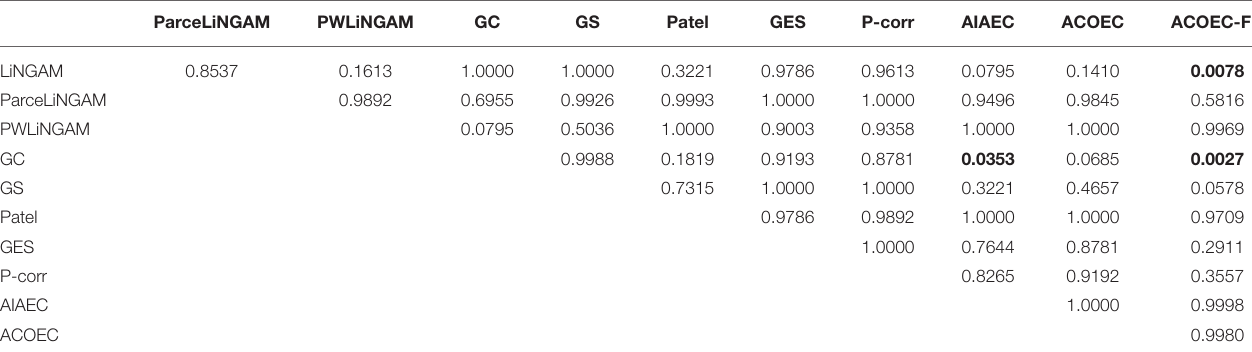
TABLE 5 | The post-hoc test results of p -values on PRE value.